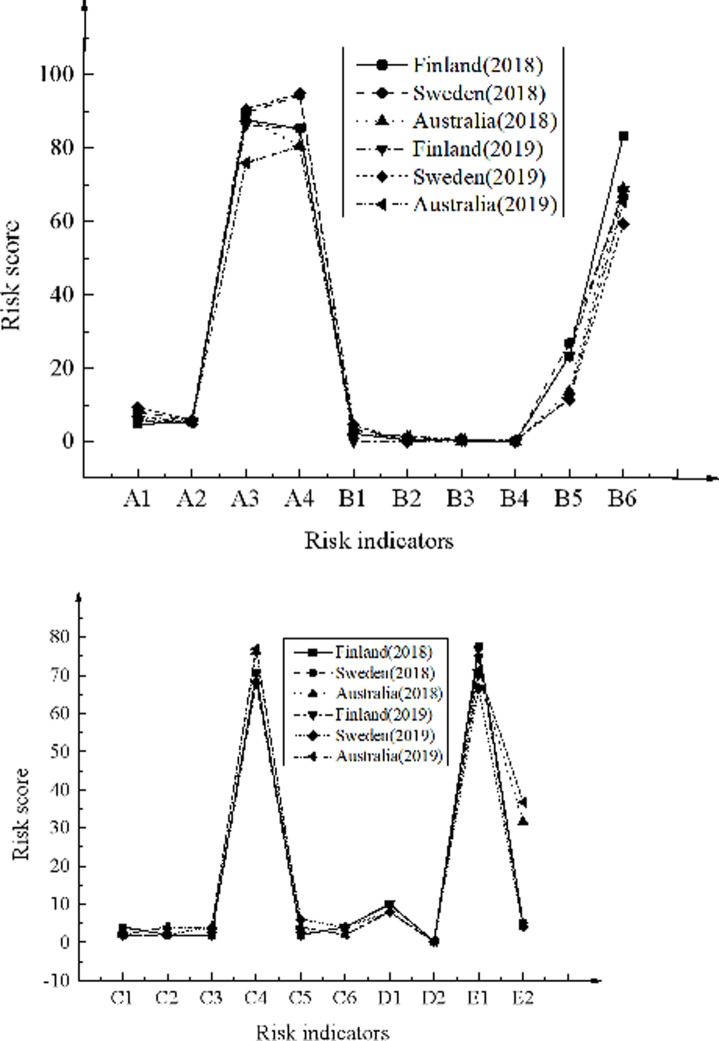
The results of the overseas investment risk assessment of European and Oceanian country clusters in 2018–2019.(a) Risk categories of basic resources and economic and finance; (b) Risk categories of political systems, environmental protection, and resources and energy.